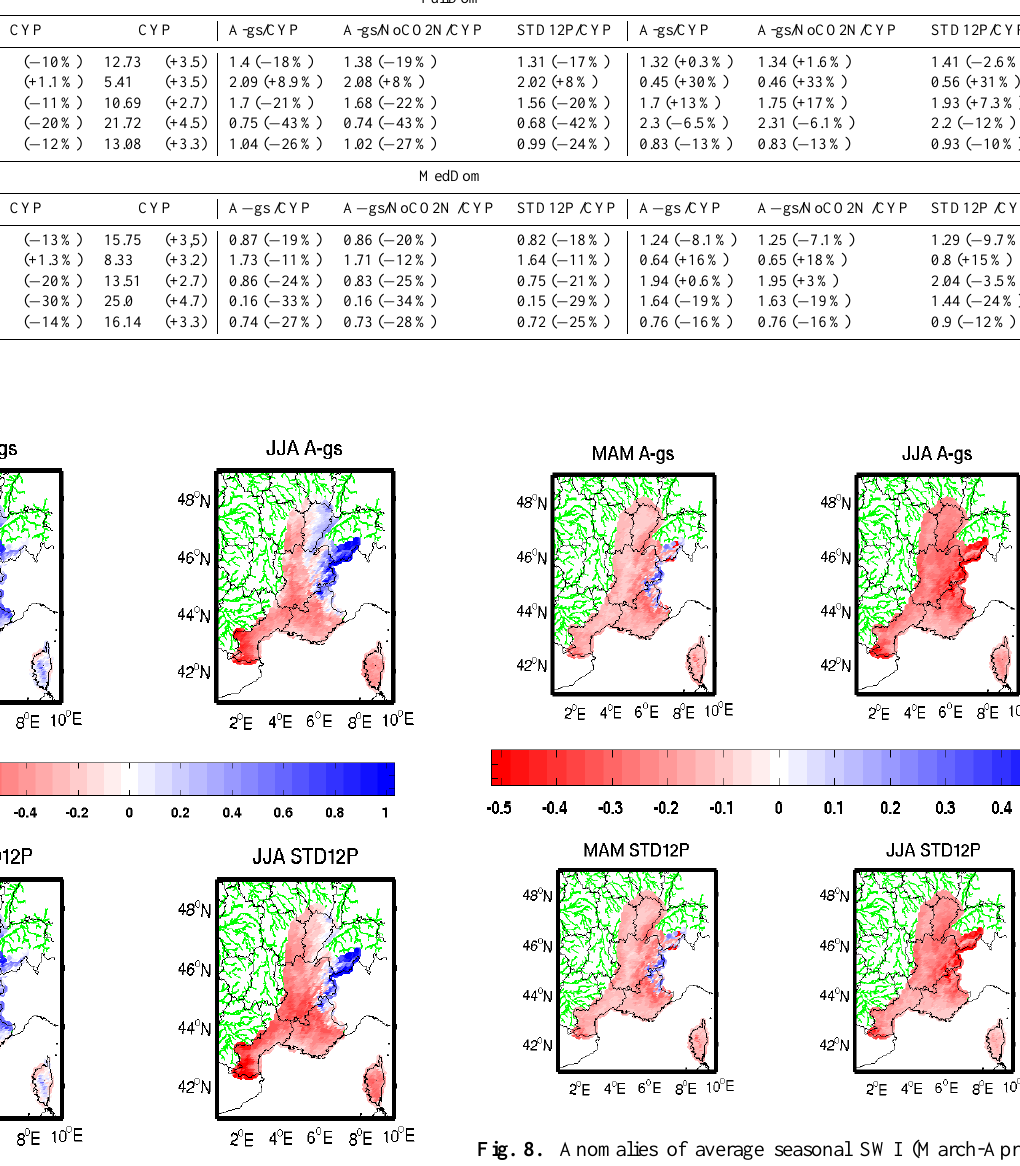
Figure 7: Anomalies of average seasonal evapotranspiration (March-April-May and June-1 Fig. 7. Anomalies of average seasonal evapotranspiration (March- July-August) obtained with ISBA-A-gs (top) and ISBA-Standard (bottom) with the CYPRIM 2 April-May and June-July-August) obtained with ISBA-A-gs (top) scenario for both. The differences are calculated by comparing two periods: 2069-2099 vs 3 and ISBA-Standard (bottom) with the CYPRIM scenario for both. 1970-2000. 4